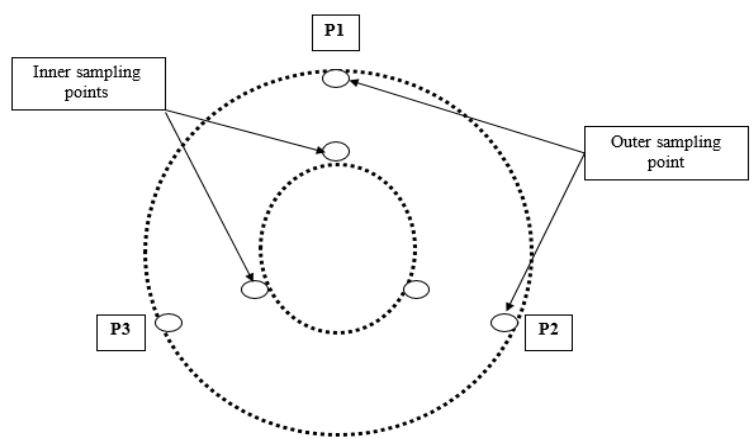
Figure 3. The transversal section of the drying chamber showing sampling points for moisture determination.